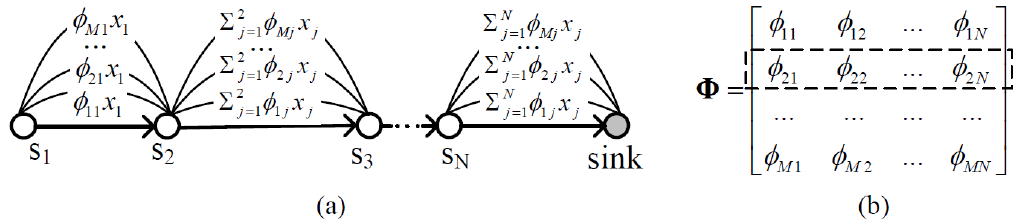
Figure 1. Relationship between routing and projection matrix: ( a ) Routing process; ( b ) Projection